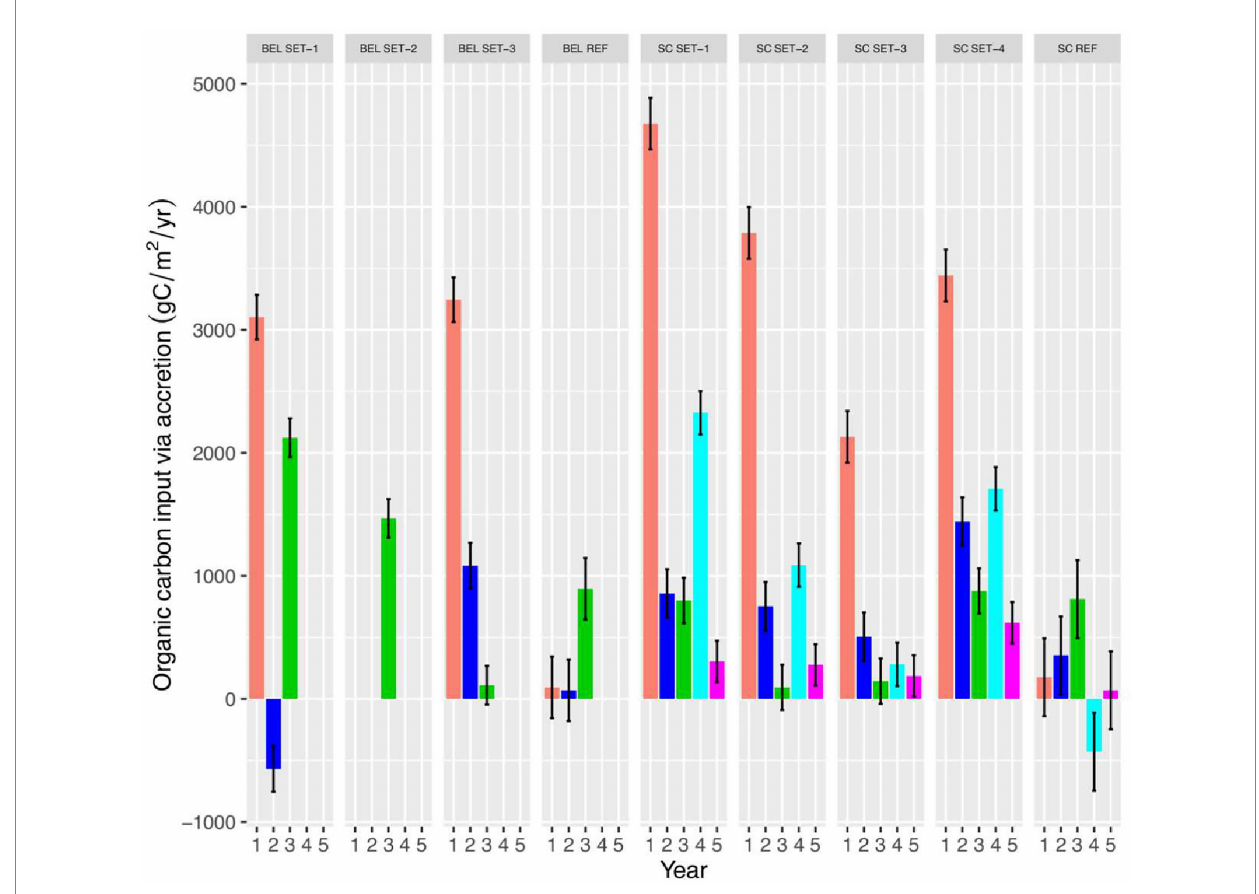
FIGURE 12 Estimated organic carbon input via sediment accretion over time at BEL and SC restoration